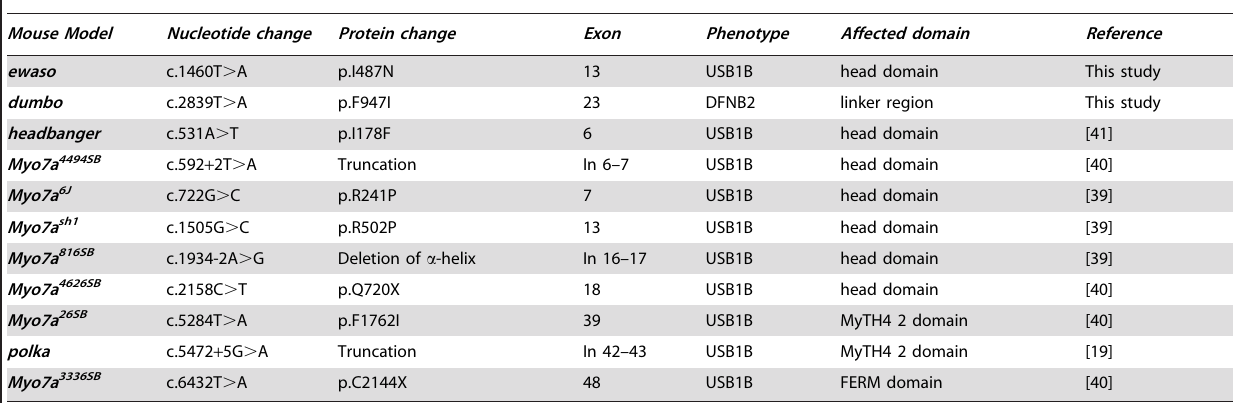
Table 1. Reported Myo7a mouse